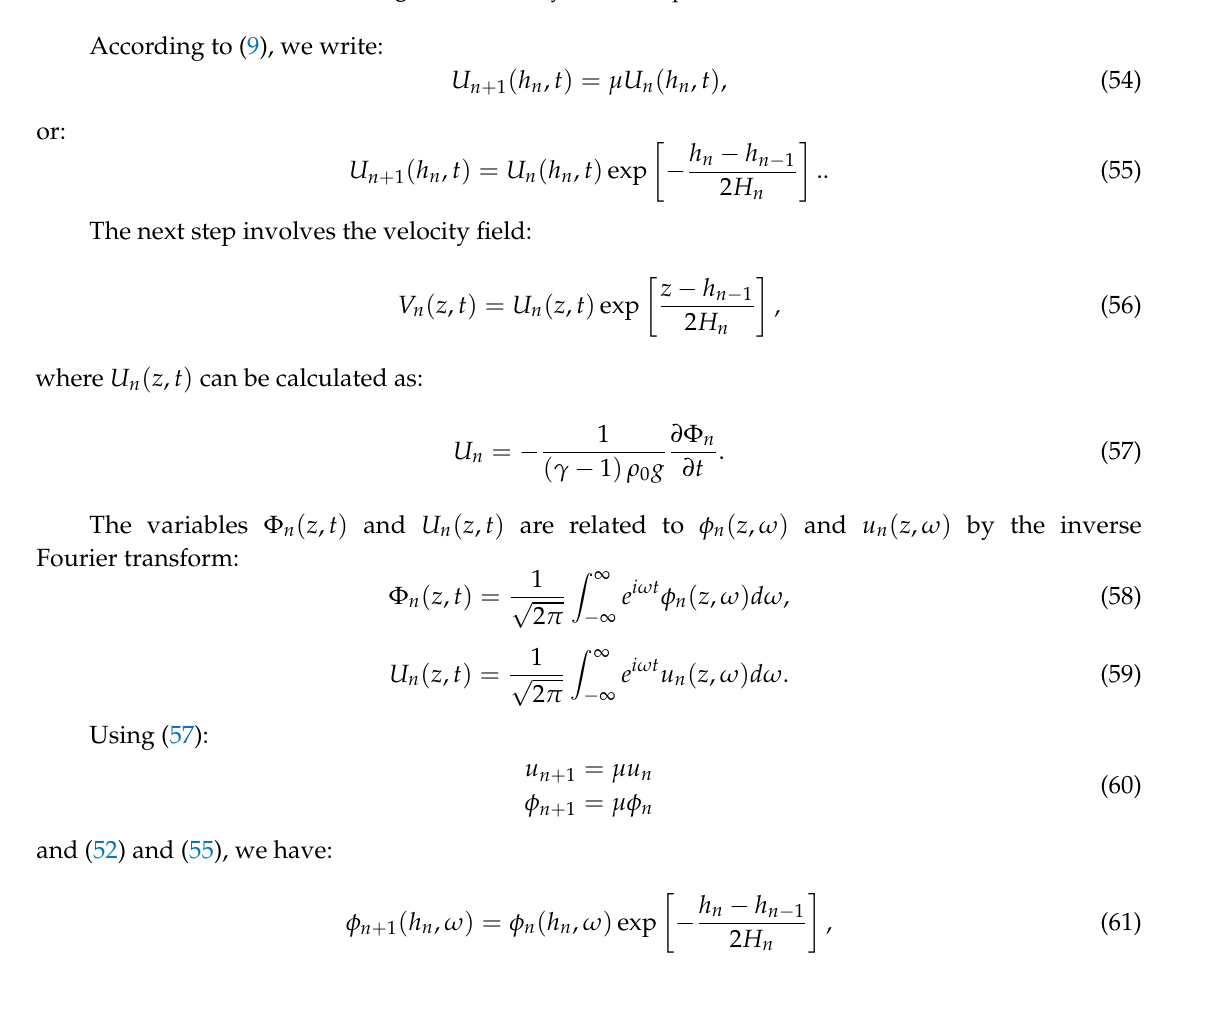
Figure 1. Multi-layered atmosphere